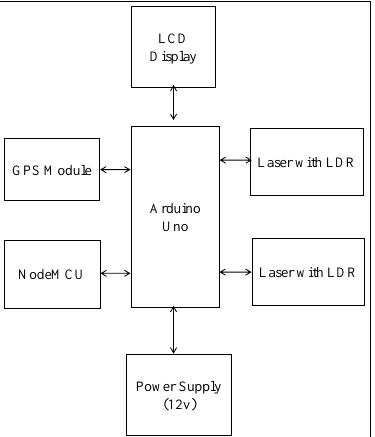
Figure 7. Framework of developed smart bus